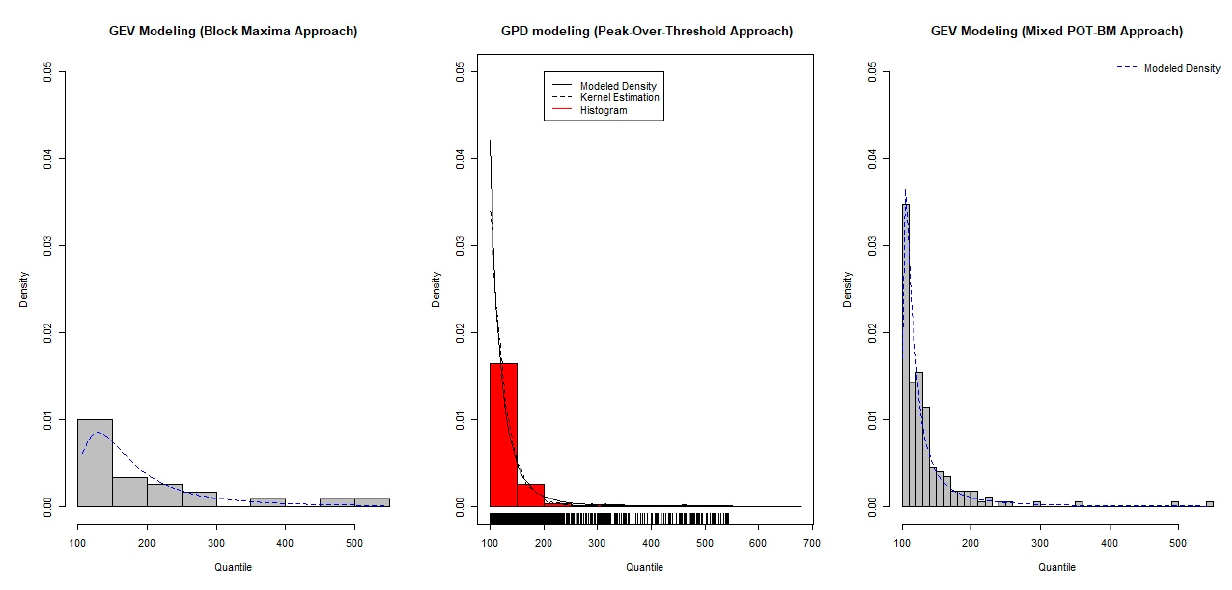
Figure 5. Comparison of fitted models.